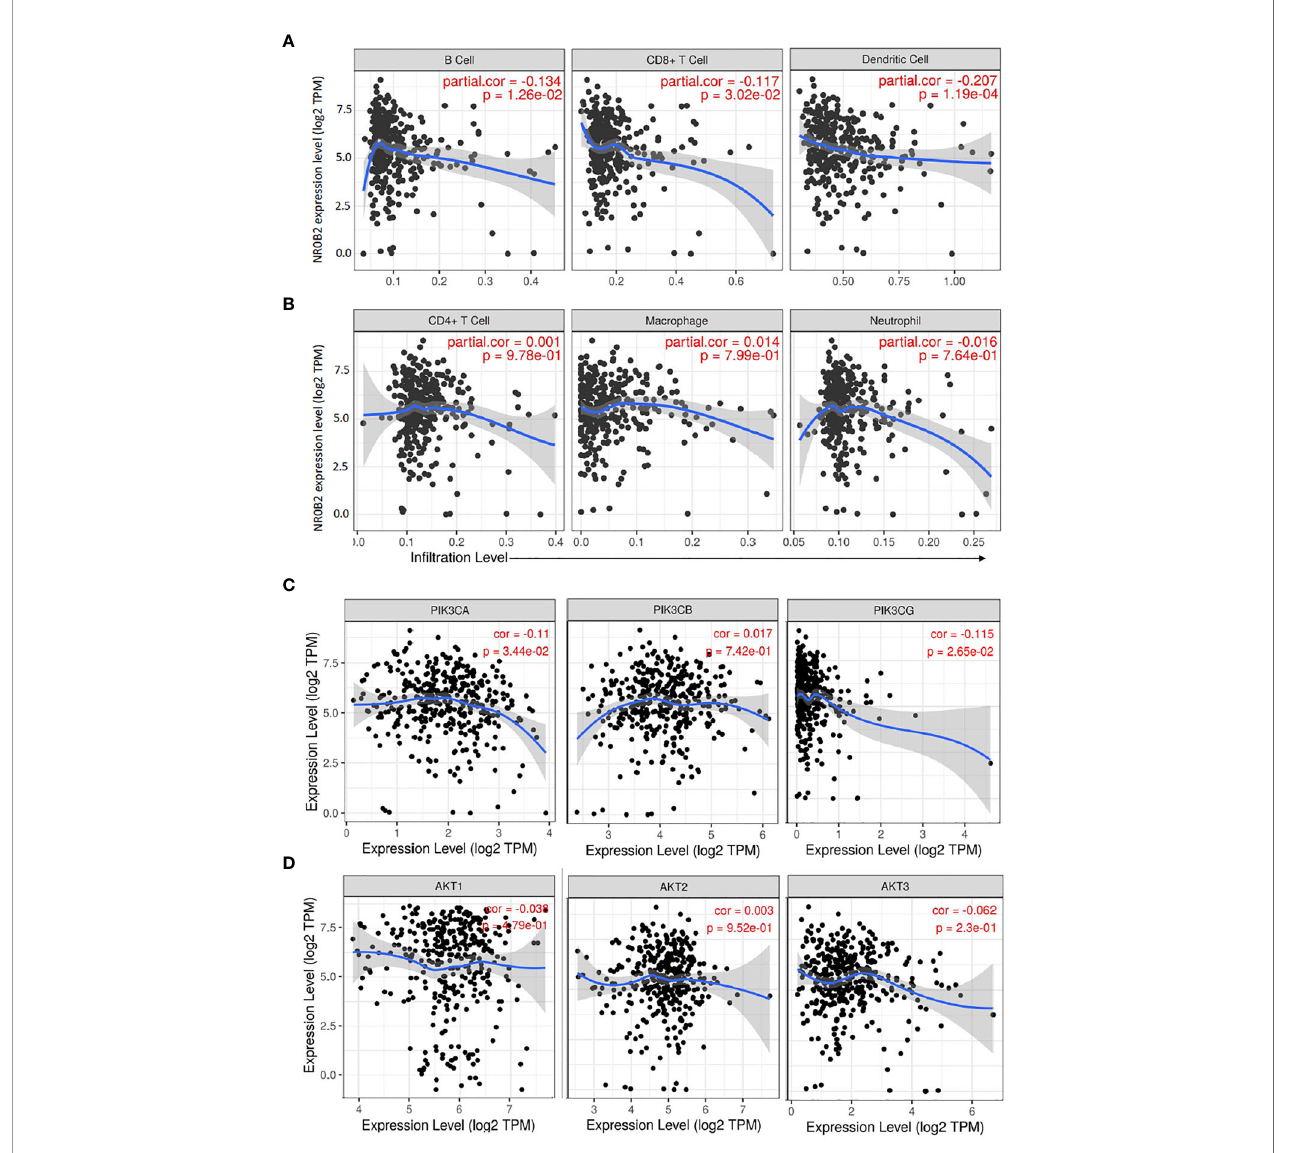
FIGURE 4 | Correlation analysis between NR0B2 expression and tumor-in fi ltrating immune cells, as well as PI3K/AKT gene expression in liver cancers. (A, B) The Gene module on the Tumor Immune Estimation Resource (TIMER) platform was used to visualize the correlation between NR0B2 gene expression and immune in fi ltration levels in liver cancer tissues (16, 17). Scatterplots show a negative correlation of NR0B2 expression with tumor-in fi ltrating B-cell, CD8 + T cell, and dendritic cell but not CD4 + T cell, macrophage, and neutrophil. The partial Spearman ’ s rho value and statistical signi fi cance were inserted in the plot. (C, D) The Correlation module on the Tumor Immune Estimation Resource (TIMER) platform was used to visualize the correlation between NR0B2 gene expression and class IA PI3K genes in liver cancer tissues (16, 17). Scatterplots show a negative correlation of NR0B2 expression with PIK3CA and PIK3CG gene expression but not with PIK3CB and ATK1-3 genes. The Spearman ’ s rho value and statistical signi fi cance were inserted in the